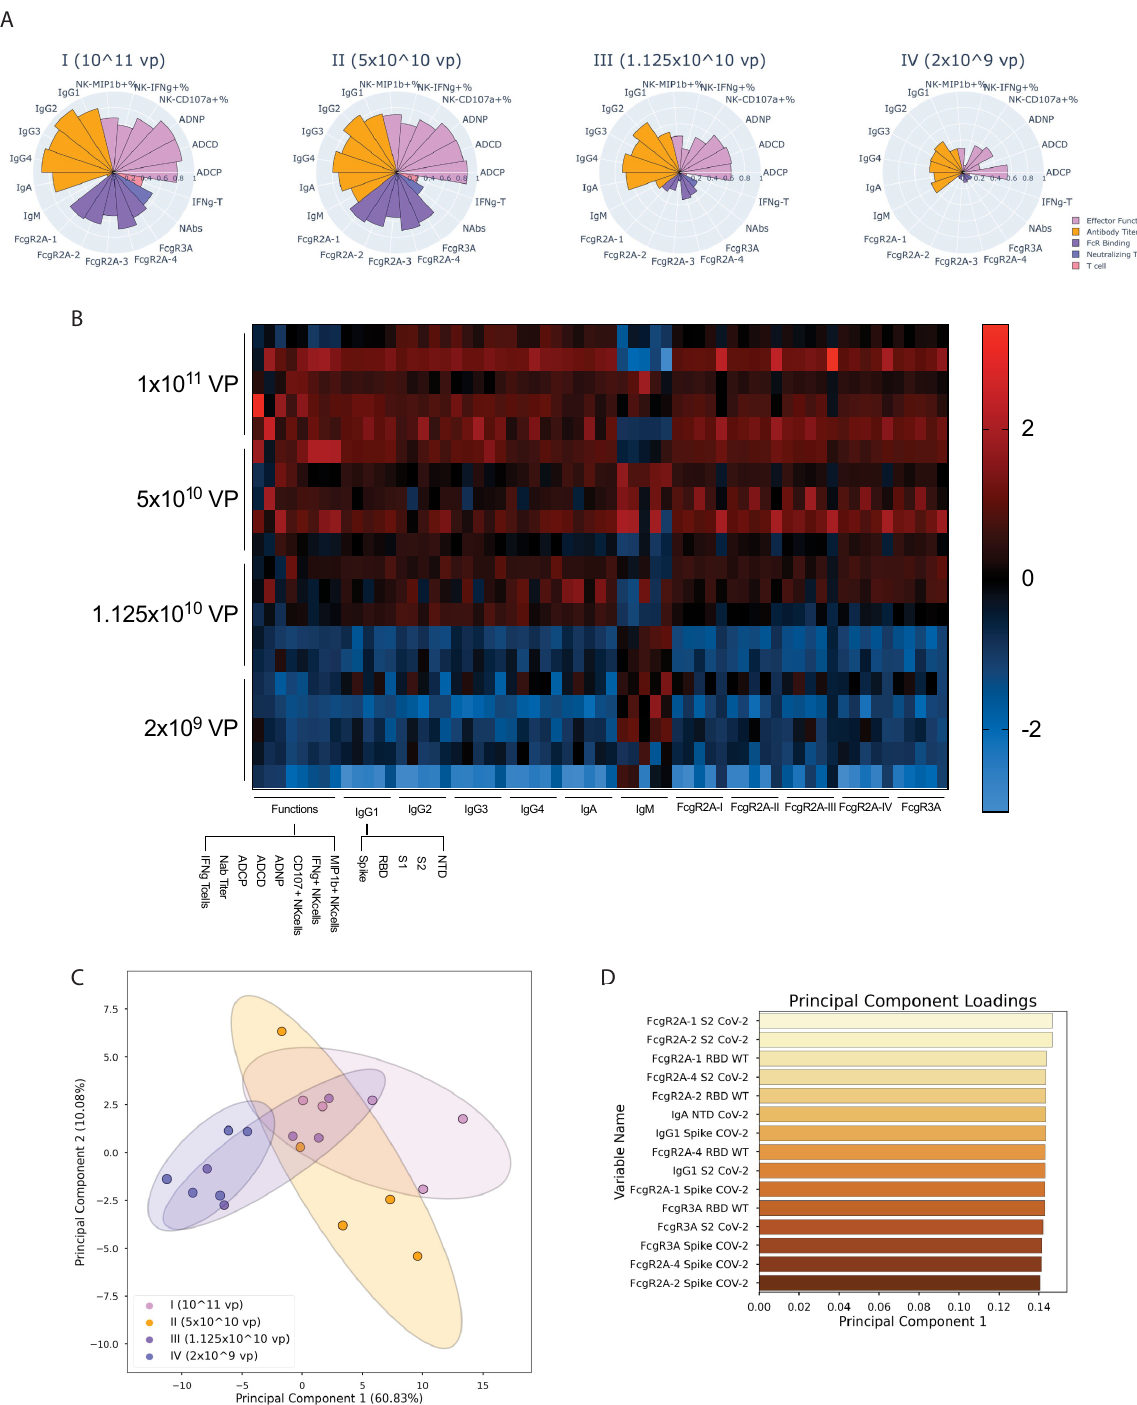
Fig 3. Multivariate analysis of the humoral response among each vaccine regimen. Further analysis was performed to identify which humoral features defined the response in each dose. (A) Polar plots showing the mean percentile of each of the anti–SARS-CoV-2 antibody titers, FcR binding, and effector function activation features for NHPs, grouped by the approximate number of VPs received in the vaccine dose. Each wedge represents an individual feature, with colors representing the type of feature: orange: effector function; lavender: antibody titer; violet: FcR binding; indigo: neutralizing titer; and pink: T-cell cytokine secretion. (B) The heatmap shows the humoral response, antibody isotype, and FcR